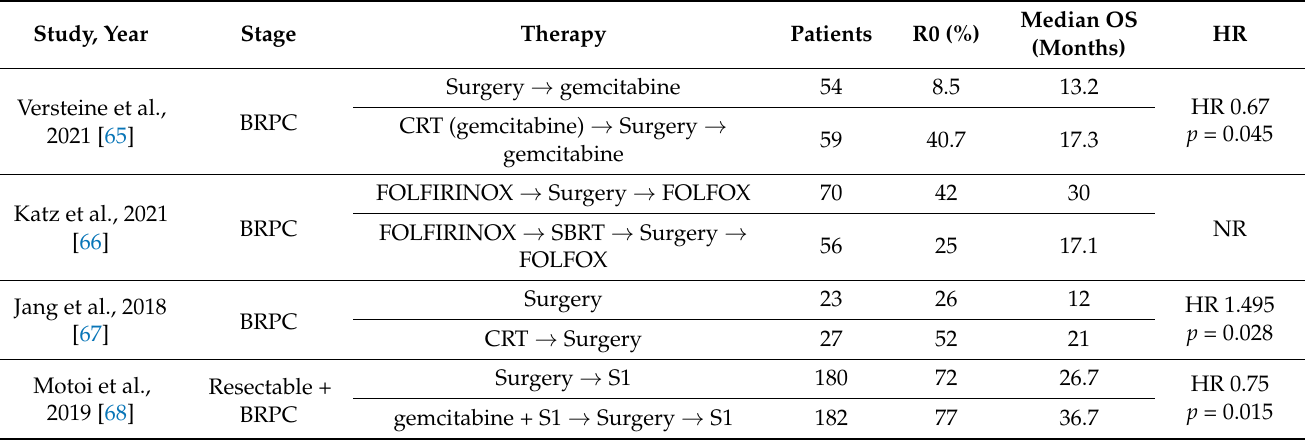
Table 2. Selected studies evaluating the treatment of